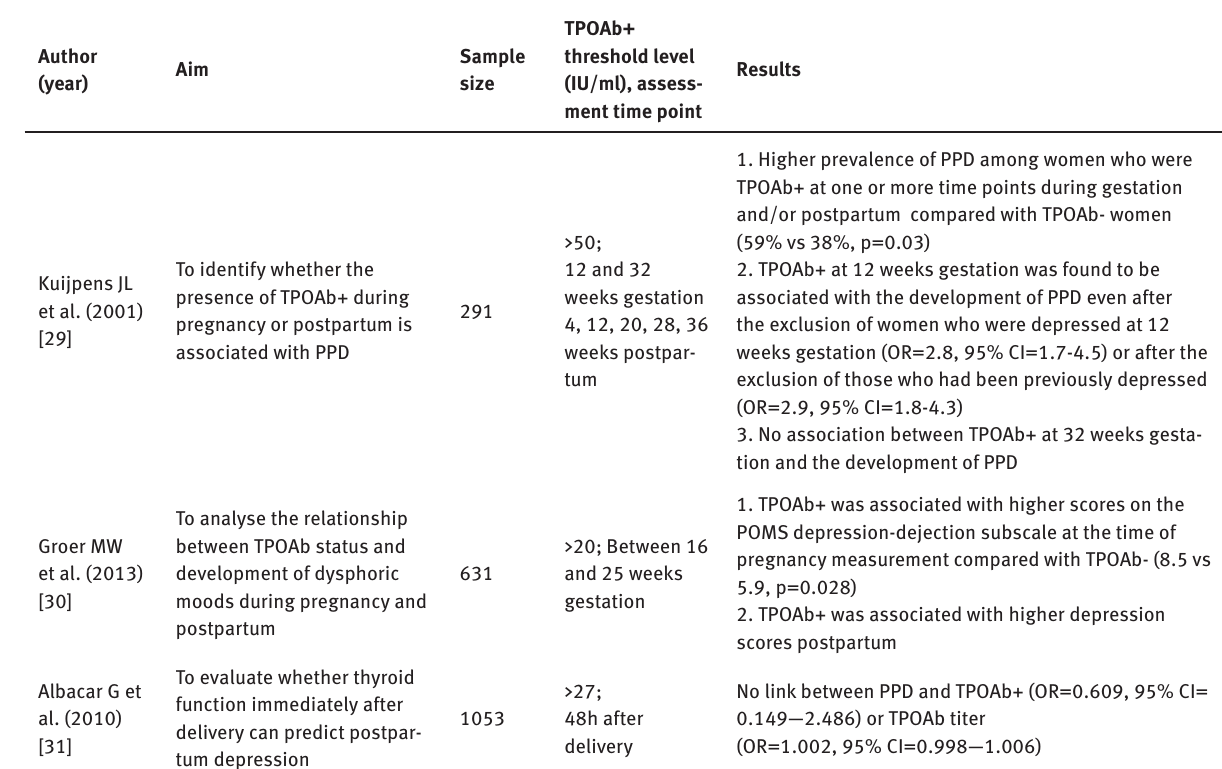
Table 3: Studies assessing the link between thyroid autoimmunity and postpartum depression